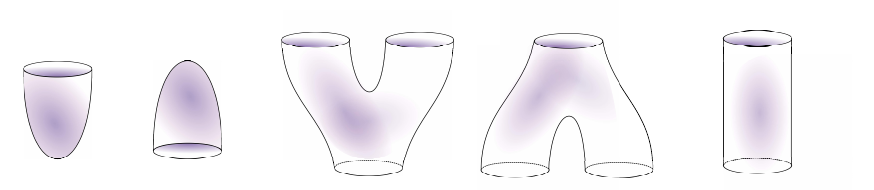
Figure 9. The building blocks of a surface. Given a scalar function f defined on a surface M , Theorem 2 asserts that we can decompose the surface into the building block pieces appear in above. These pieces are genus zero surfaces with a single boundary component (disk), genus zero surfaces with three boundary components (pair of pants), and a genus zero surface with two boundary components (cylinder).